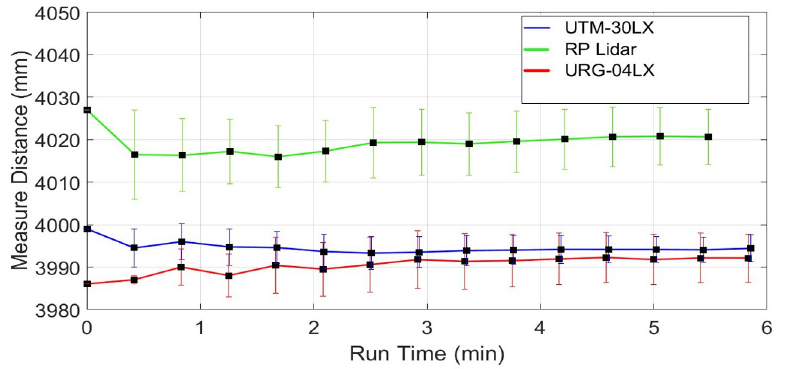
Fig 22. Plot of mean and standard deviations values for white color object.